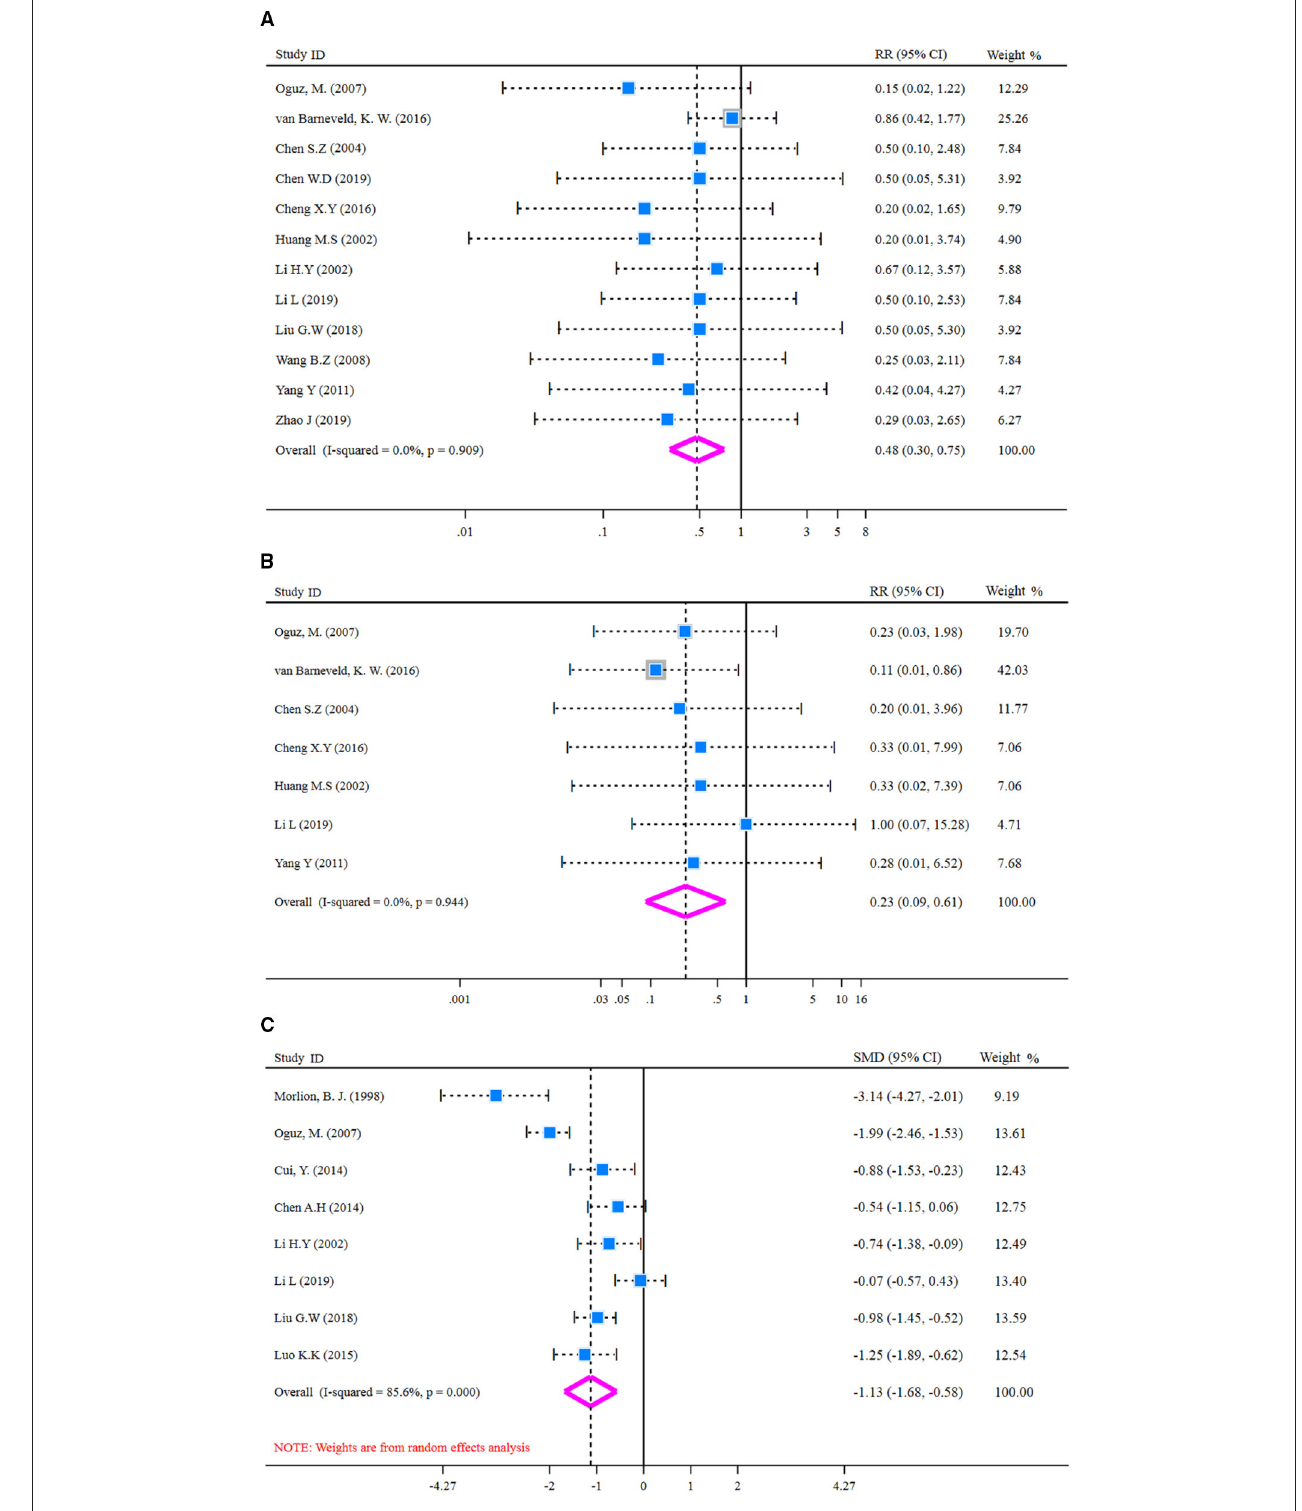
FIGURE 5 | Forest plot of for SSI, anastomotic leakage, and LOS. (A) Forest plot of SSI applied a fixed effect model; (B) Forest plot of anastomotic leakage applied a fixed effect model; (C) Forest plot of LOS applied a random effect model. SSI, surgical site infection; LOS, length of hospital stay.